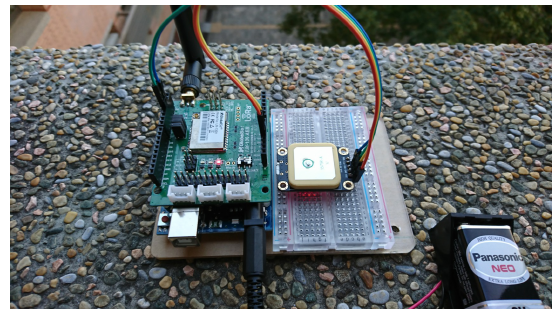
Figure 12. The Equipment of Packet Loss Rate